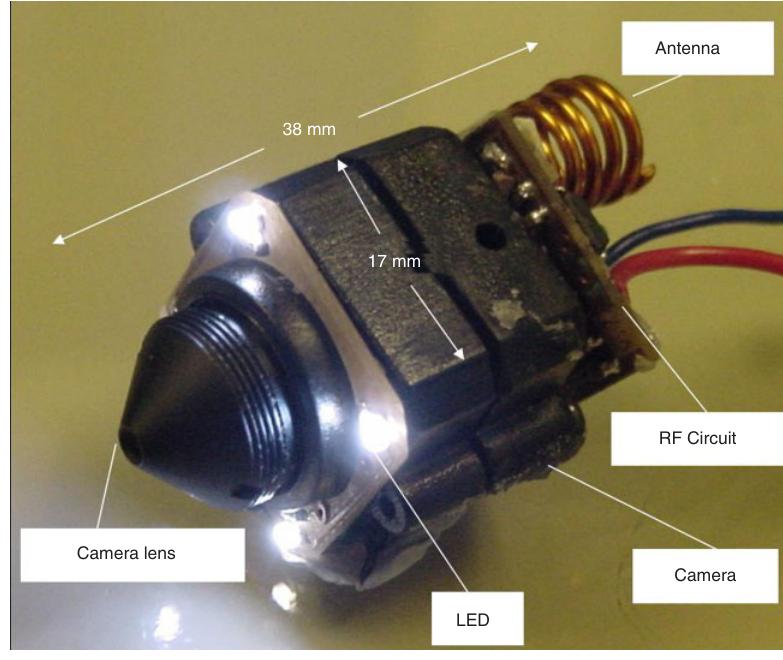
Figure 9 A picture of the WCE prototype of solution 1. LED is light-emitting diode.